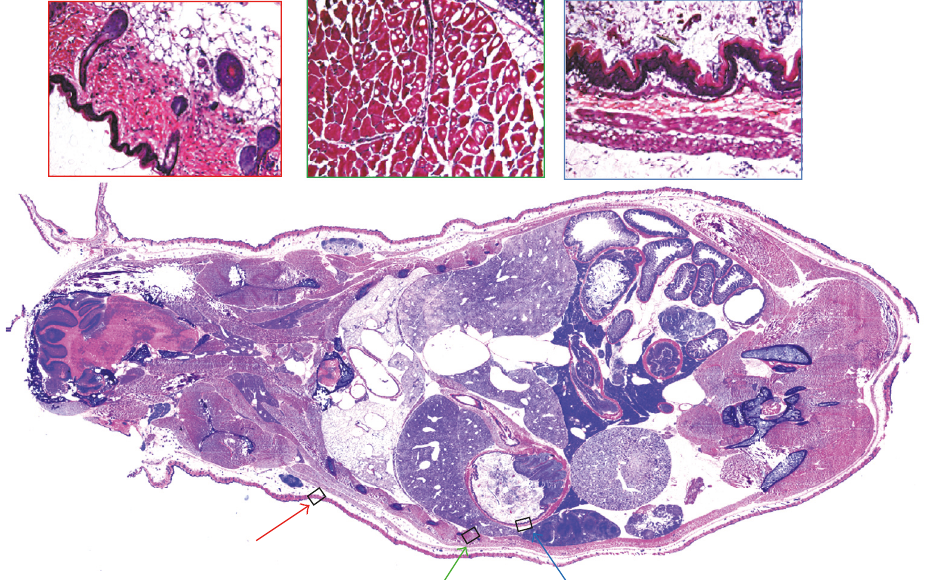
Figure 6: Whole mouse histology section acquired with adhesive film. H&E stained. Figures on the right in red, green, and blue boxes are zoomed images obtained at arrows having the same colors in the whole mouse histology